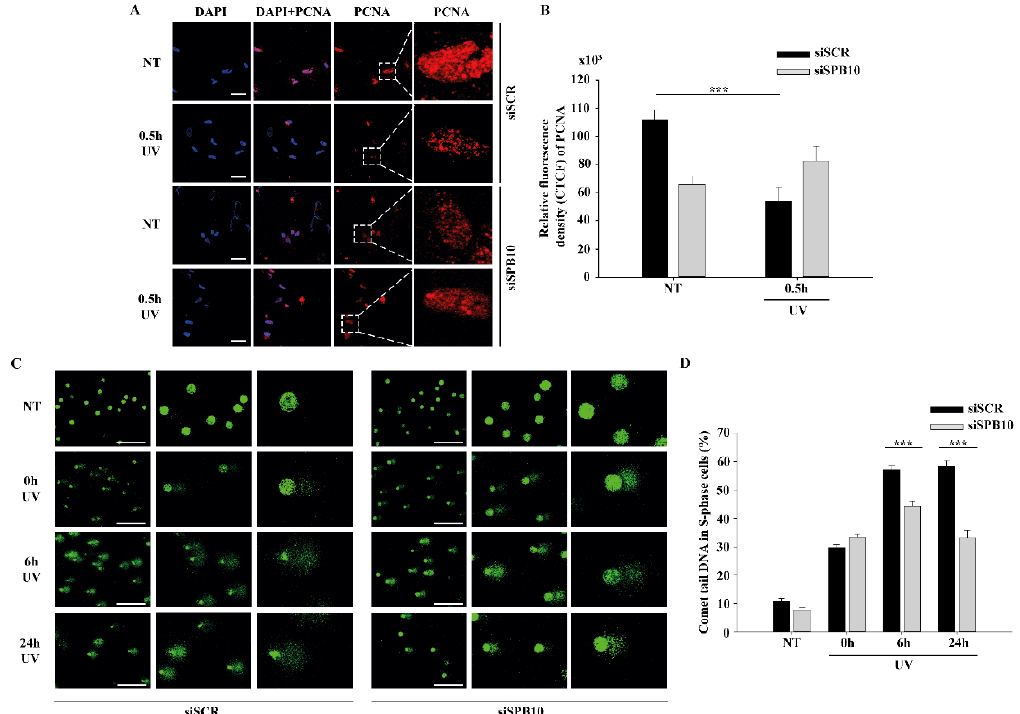
Figure 3. SPB10 influences DNA repair kinetics in S-phase cells upon UV irradiation: ( A ) Representative images of PCNA protein (red) binding in non-targeting (siSCR, upstream) and SPB10 siRNA-silenced ( siSPB10 , downstream) U2OS cells in basal conditions (NT) and after UV irradiation (0.5 h). Only the chromatin-bound proteins were visualized by CSK- immunocytochemistry. DAPI (blue) was used to visualize the nuclei. Scale bars represent 200 µ m. For each condition, a higher magnification of a single cell is shown on the right side of the figure. ( B ) Quantification of relative fluorescence intensity (CTCF) based on measured foci number of proliferating cell nuclear antigen (PCNA) protein detected of non- targeting (siSCR) and SPB10 siRNA-silenced U2OS cells in basal conditions (NT) and following UV irradiation (0.5 h). Asterisks indicate statistical significance between datasets (Mann – Whitney test, *** p ≤ 0.001). ( C ) Representative images of comet tail formation in non-targeting (siSCR, left) and SPB10 siRNA-silenced ( siSPB10 , right) bromodeoxyuridine (BrdU)-labelled S-phase U2OS cells in basal conditions (NT) and after UV irradiation (0, 6, and 24 h). Scale bars represent 200 µm. ( D ) Quantification of comet DNA tails detected on non-targeting (siSCR) and SPB10 siRNA-silenced S-phase U2OS cells in basal conditions and following UV irradiation (0, 6, and 24 h). Asterisks indicate statistical significance between datasets (Mann-Whitney test, *** p ≤ 0.001).